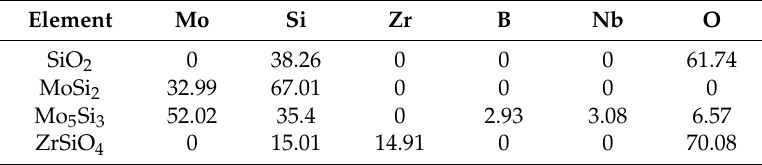
Table 3. The EDS results of constituent phase of the oxidized mz45 sample (at.%). Element Mo